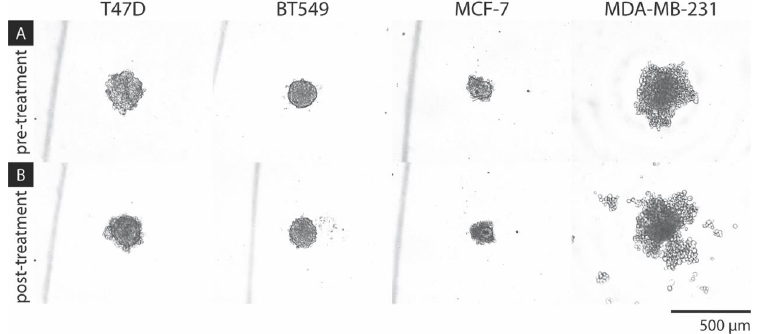
Figure 3. Breast cancer cell line aggregate test spheroids ( A ) 24 h post-cell seeding and ( B ) 96 h post-DOX treatment (5 μM), taken at 5x objective.